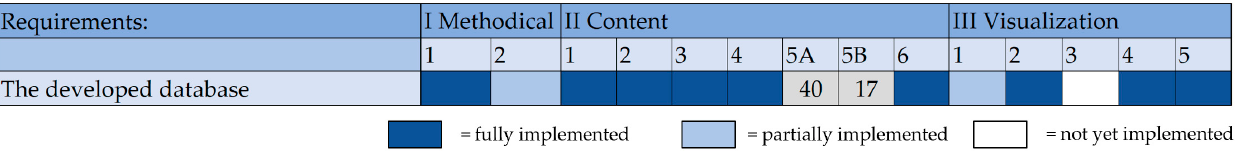
Figure 18. Evaluating the developed web-based database against the requirements